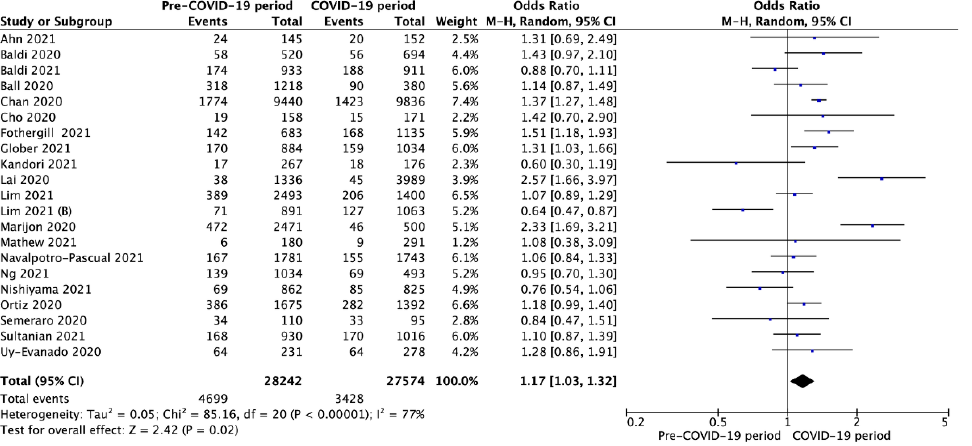
Figure 3. Forest plot of occurrence of shockable rhythm in pre- vs. intra-COVID-19 periods. The center of each square represents the weighted odds ratios for individual trials, and the corresponding horizontal line stands for a 95% confidence interval. The diamonds represent pooled results. Legend: CI = confidence interval; OR = odds ratio. Pooled analysis of resuscitation outcomes are presented in Table